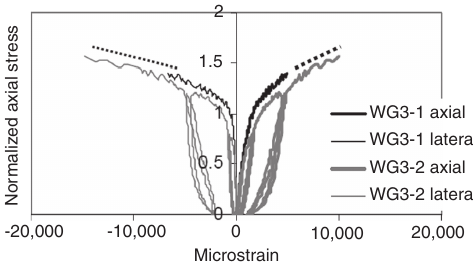
Figure 5 WC1 specimens: (A) normalized axial stress versus volu- metric strain, (B) normalized strain versus volumetric